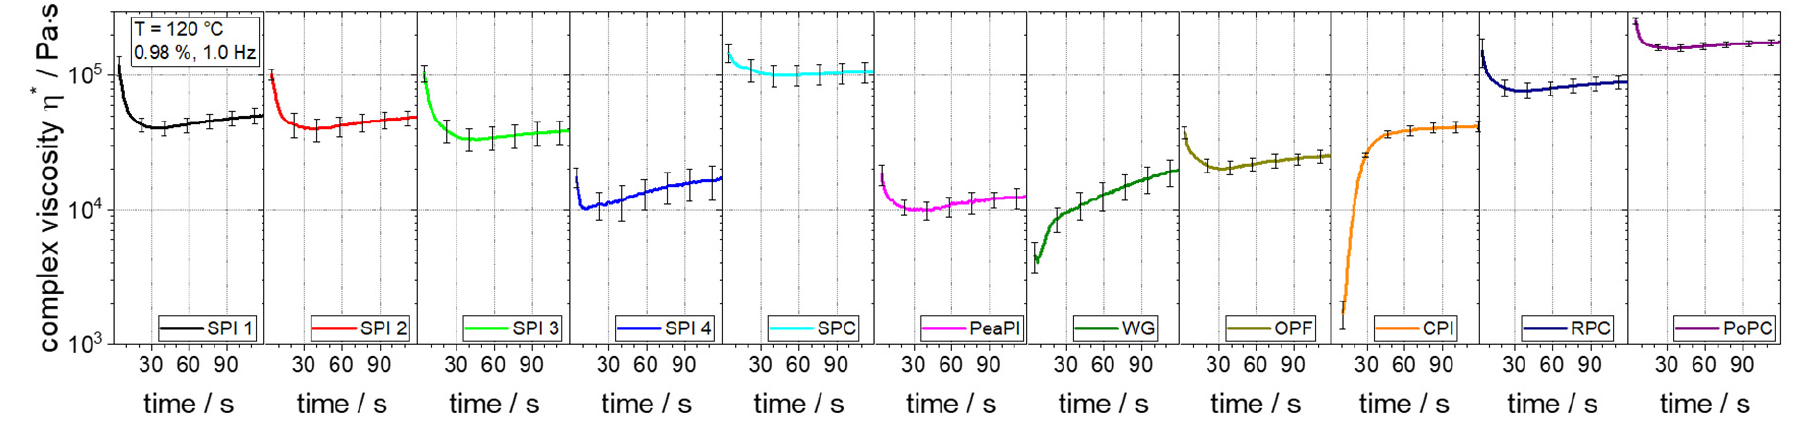
Figure 2. Time sweeps at 120 ◦ C and 0.98%/1.0 Hz of different raw materials at a moisture content of 30%.